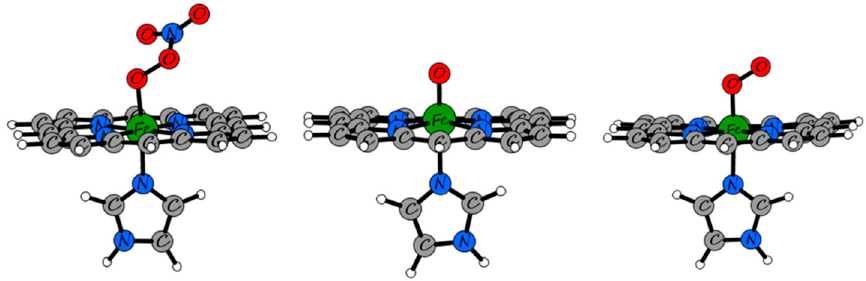
Figure 6. M06-L/6-311g(d,p)-optimized models used in the TD-DFT calculations .